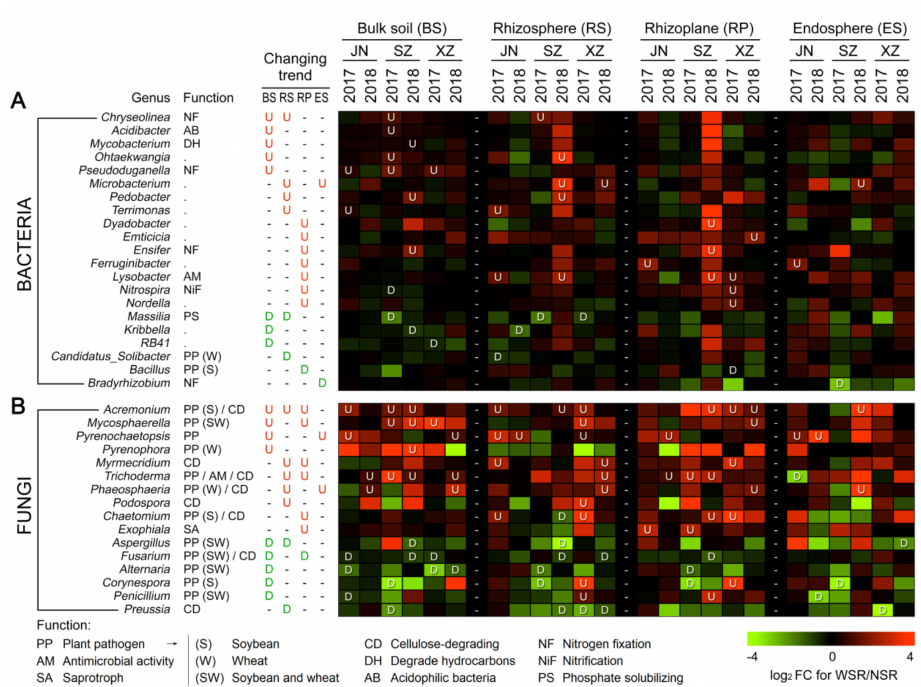
Figure 5. WSR-responsive genera of bacteria ( A ) and fungi ( B ) in each compartment, site, and year. The color of the heat map indicates the log 2 fold change in relative abundance with respect to the control treatment, i.e., WSR/NSR: an increase tends toward red, while a decrease tends toward green. On the heap map, “U” and “D” mean that the relative abundance significantly increased and decreased, respectively ( p < 0.05, Wilcoxon rank-sum tests). For the columns of “Changing trend”, “U” and “D” represent a consistently increasing and decreasing trend in the indicated compartment, respectively. A consistent changing trend was defined for a genus that showed not only a significant response to WSR in at least one site or year but also a similar changing trend in at least five of the six cases (three sites × two years for one